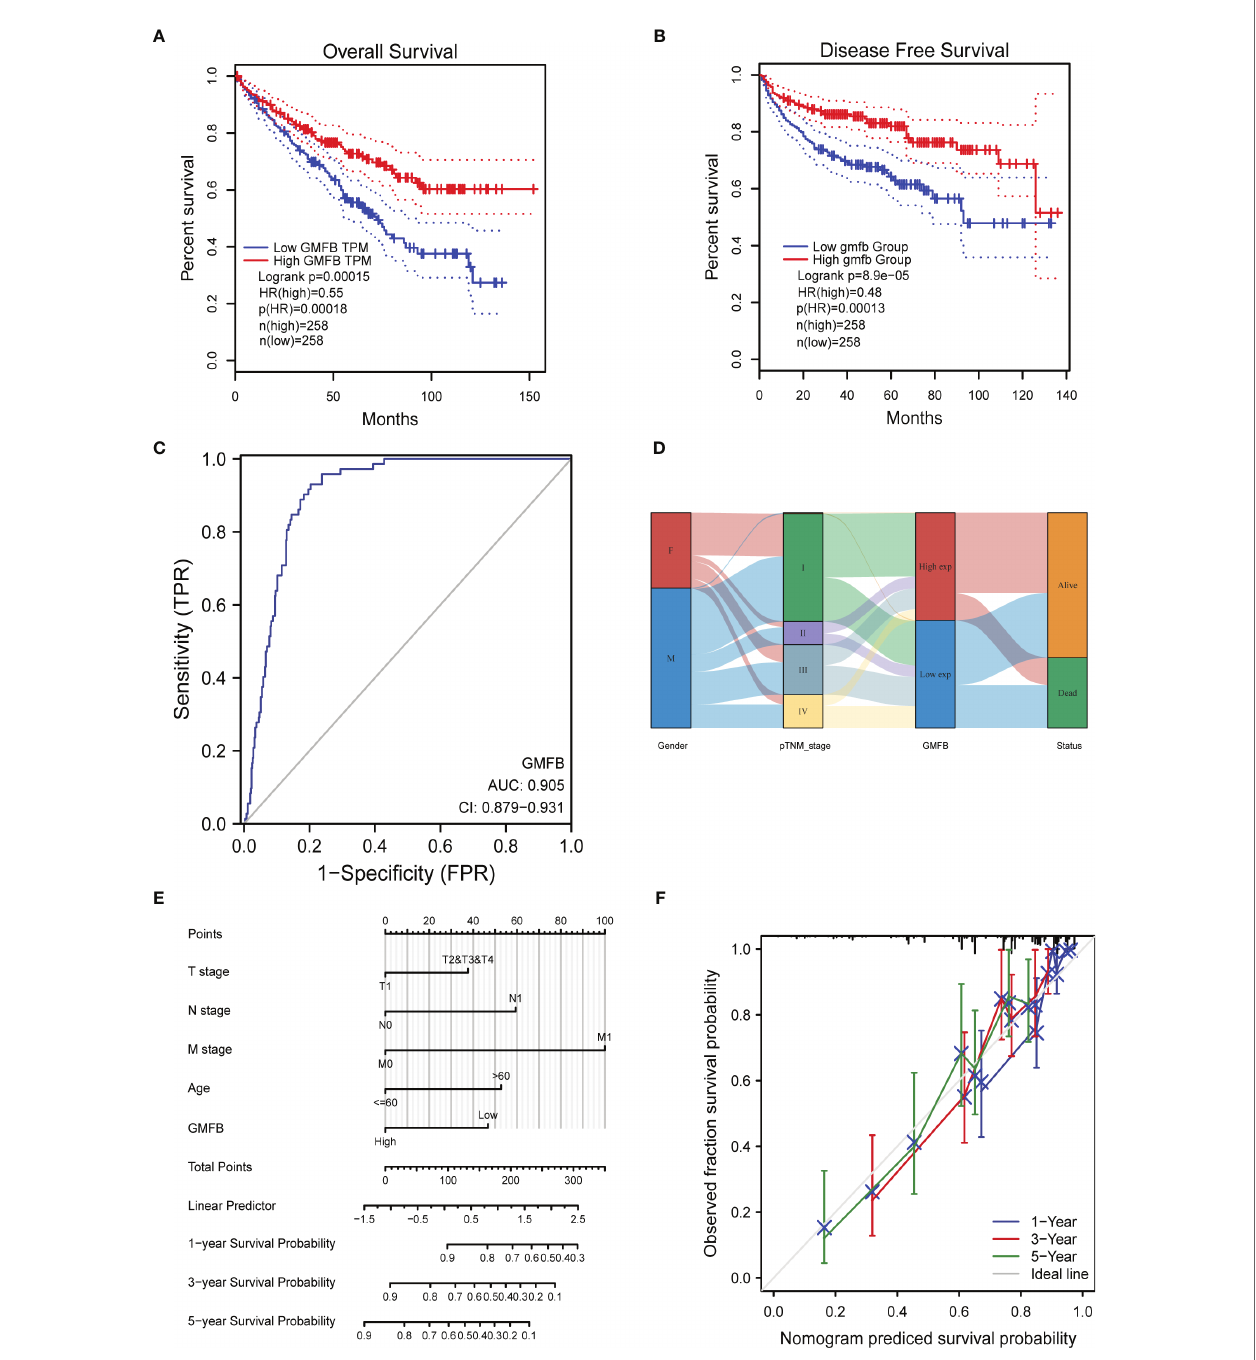
FIGURE 3 | The prognostic value of GMFB expression in kidney renal clear cell carcinoma (KIRC). (A) Kaplan – Meier survival curves for the effect of Gmfb expression on overall survival. (B) Kaplan – Meier survival curves for the outcome of GMFB expression on disease-free survival. (C) Receiver operating characteristic analysis (ROC) curve of GMFB in KIRC. (D) Gmfb expression association with different clinical characteristics shown on the Sankey diagram. (E) The integrated Gmfb and other prognostic factors in KIRC from The Cancer Genome Atlas (TCGA) data by nomogram. (F) The calibration curve of the